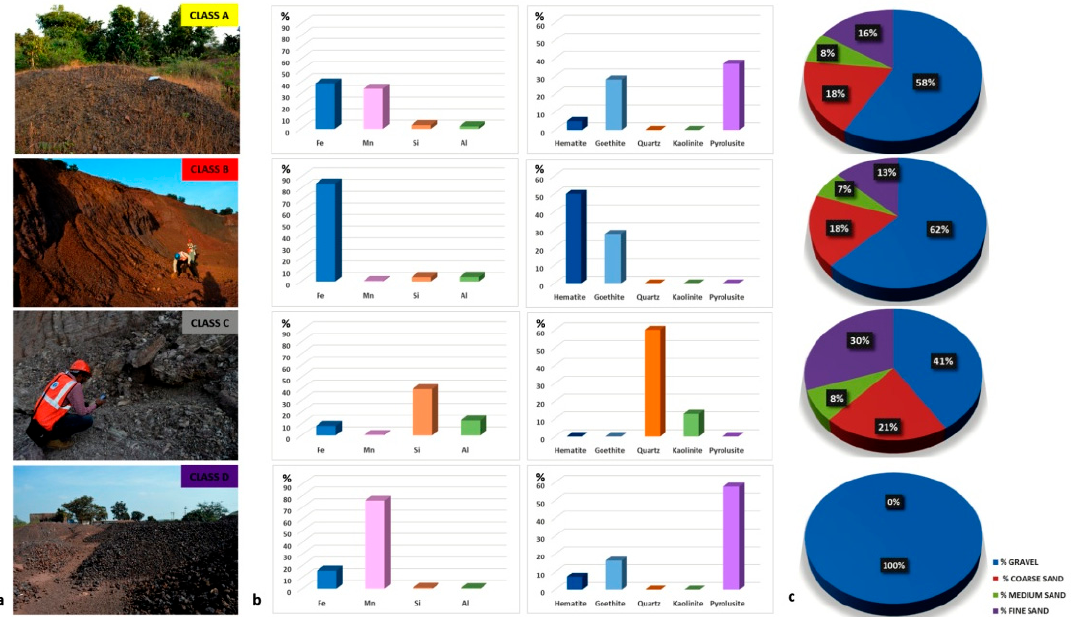
Figure 8. Description of four classes: Class A (yellow)—residues dumped in the old area of mine with the presence of sparse herbaceous vegetation; Class B (red)—residues accumulated at the foot of the mine wall where the extraction process is carried out and fresh residues accumulated along the roadside of the mine area; Class C (grey)—residues abandoned in the closed mine; Class D (purple)—residues deposits of lower-grade ores ( a ). For each class, the concentrations of the main elements and minerals (in percentage) ( b ) and the particle size distribution ( c ) are highlighted.